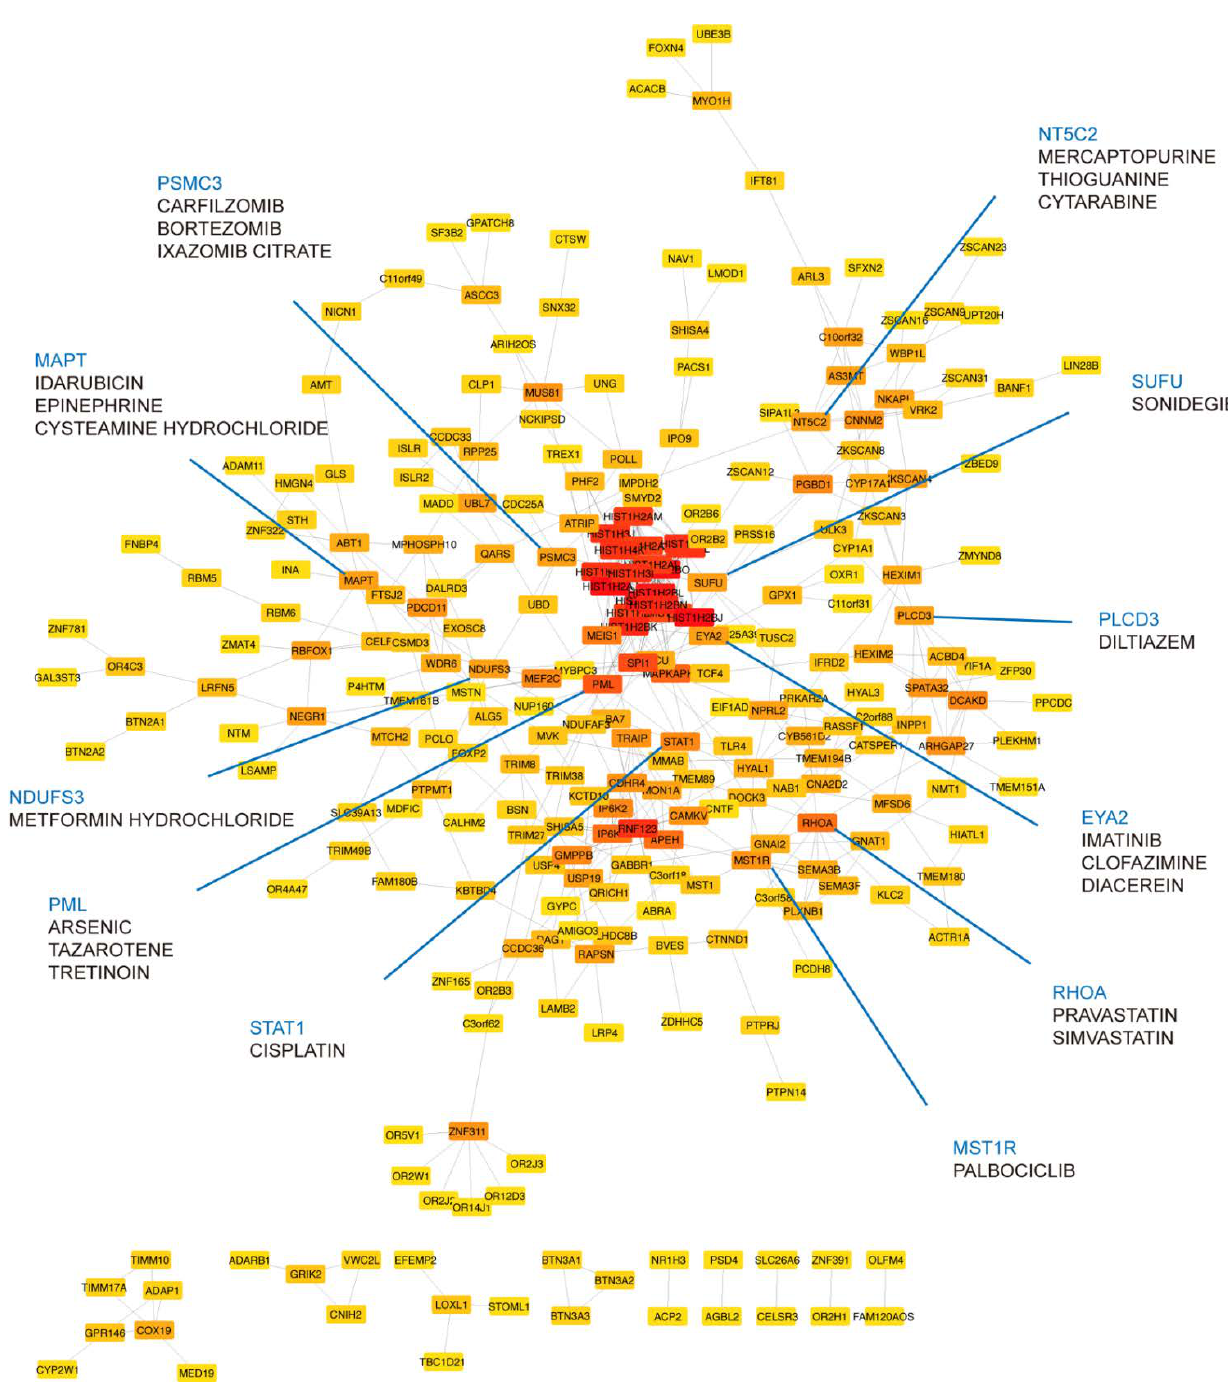
Figure 4. Druggable targets prioritized in the STRING network. A total of 272 shared genes are ordered by their connectivity degree in the network. The color of nodes from red to yellow represents the degree from high to low. Druggable targets in blue are annotated with their potential drugs (drug listed under the target gene name).